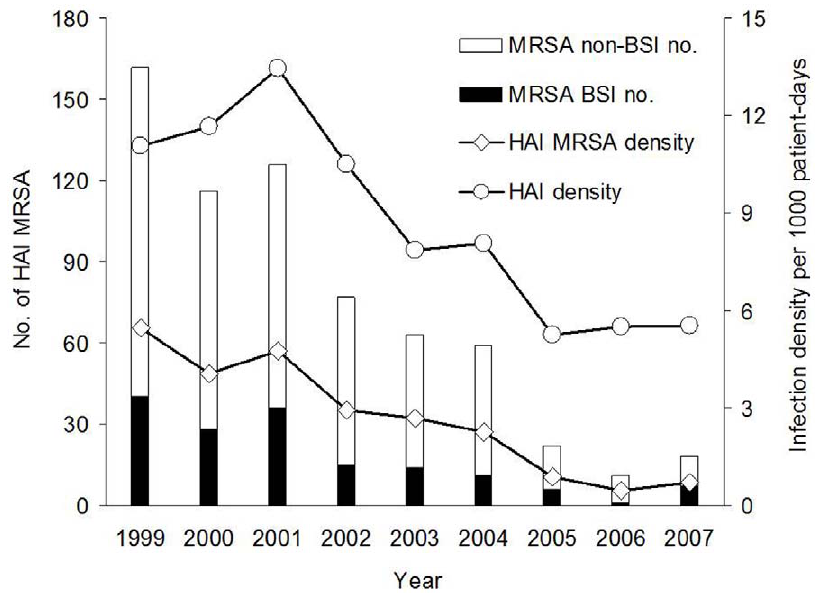
Figure 1. Healthcare-associated infection (HAI) density, overall and caused by methicillin-resistant Staphylococcusaureus (MRSA), in the neonatal intensive care units of Chang Gung Children’s Hospital significantly decreased from 1999 to 2007. HA MRSA infection episodes, overall and bloodstream, also decreased markedly.